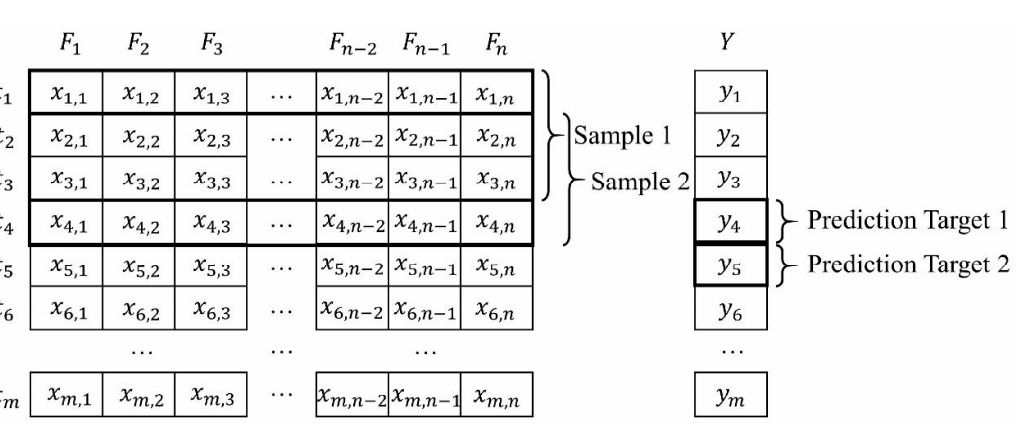
Figure 1. An example of the sliding window method, F denotes the feature column, and t denotes a record (or sample).